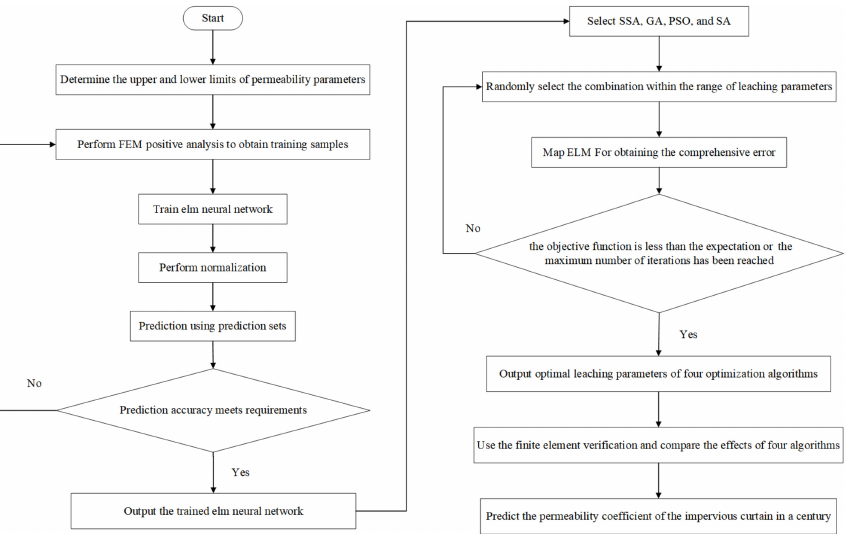
Figure 2. Flow chart of the prediction model based on ELM and optimization